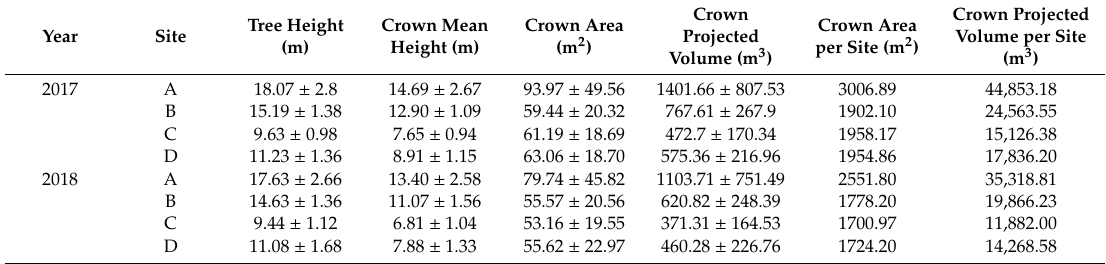
Table 3. Geometric characterization of each experimental site.